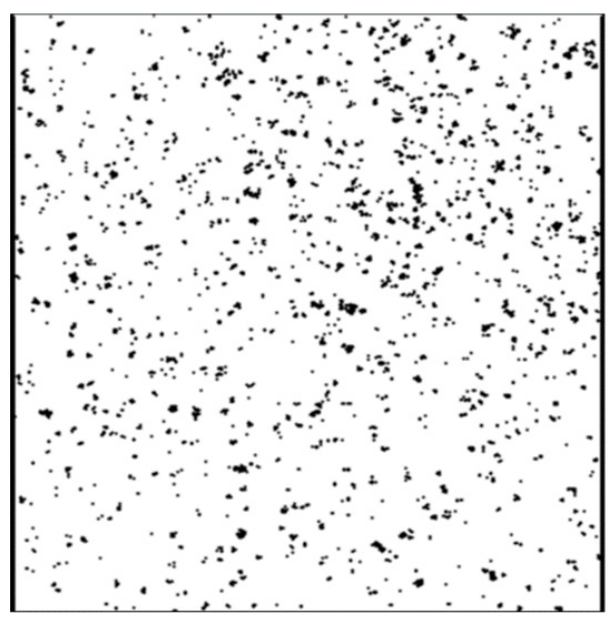
Figure 9. The surface profile after the threshold adjustment.